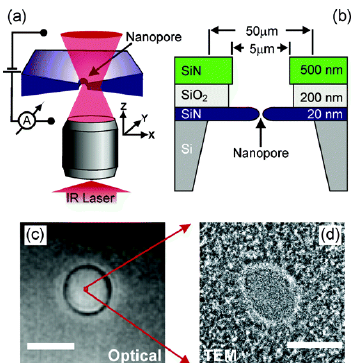
Figure 23. ( a ) Schematic image of the setup. The microscope objective focuses a laser into a diffraction-limited spot and the nanopore is scanned through the laser beam. The